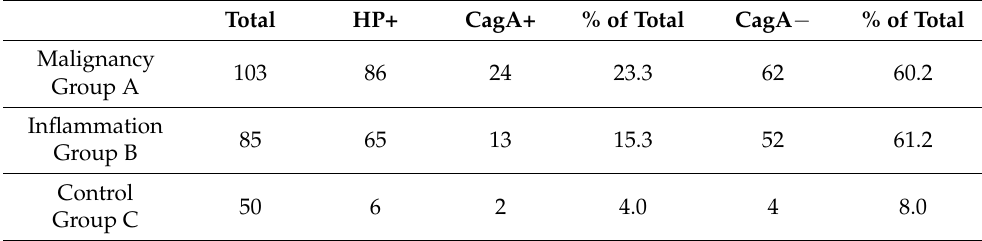
Table 2. Distribution of the CagA+ and CagA − genotypes of Helicobacter pylori in the respective groups. Total HP+ CagA+